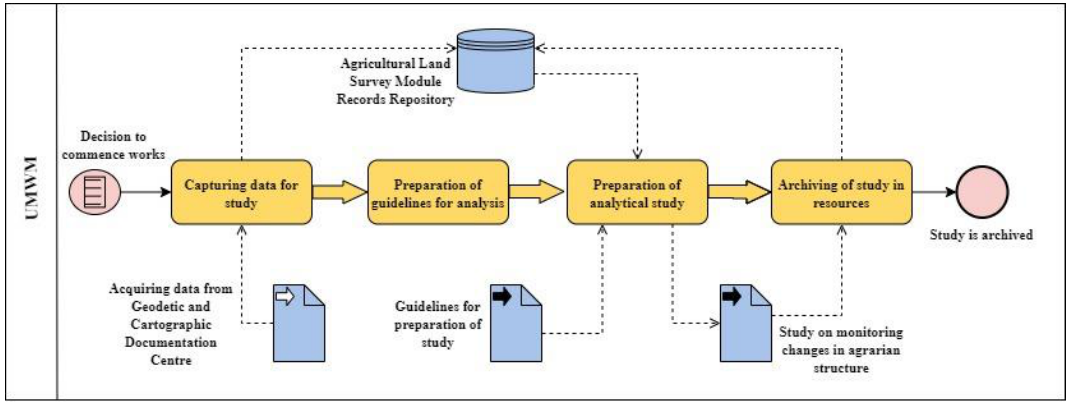
Figure 3. Developing the analysis of changes in the agrarian structure in the Marshal’s Office of the Malopolska Voivodeship (UMWM). Source: own study.